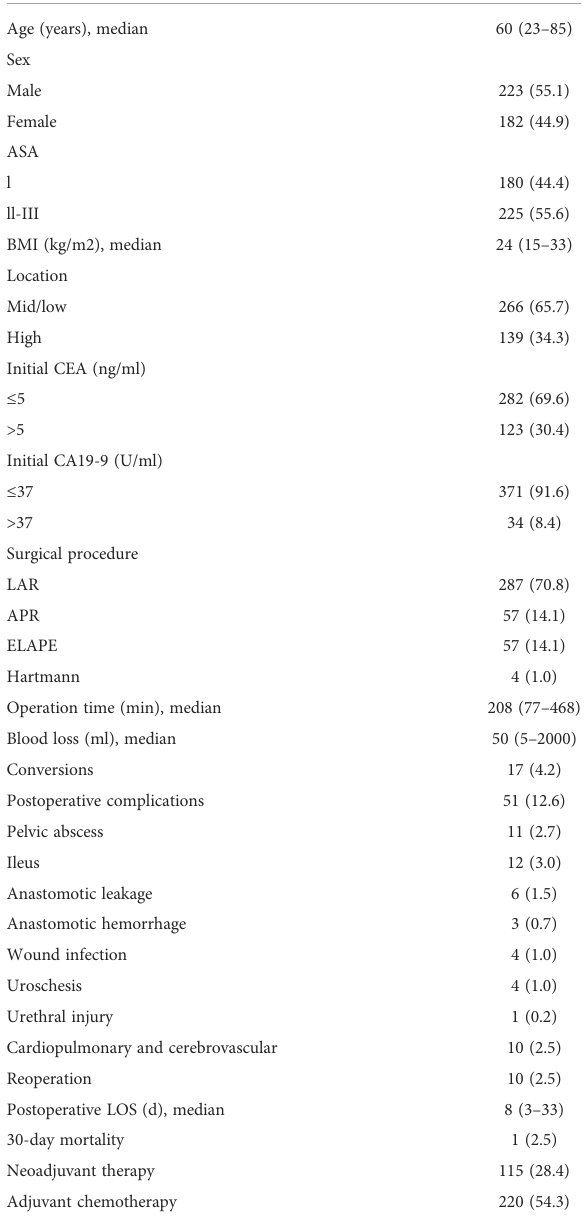
TABLE 1 Demographic and treatment